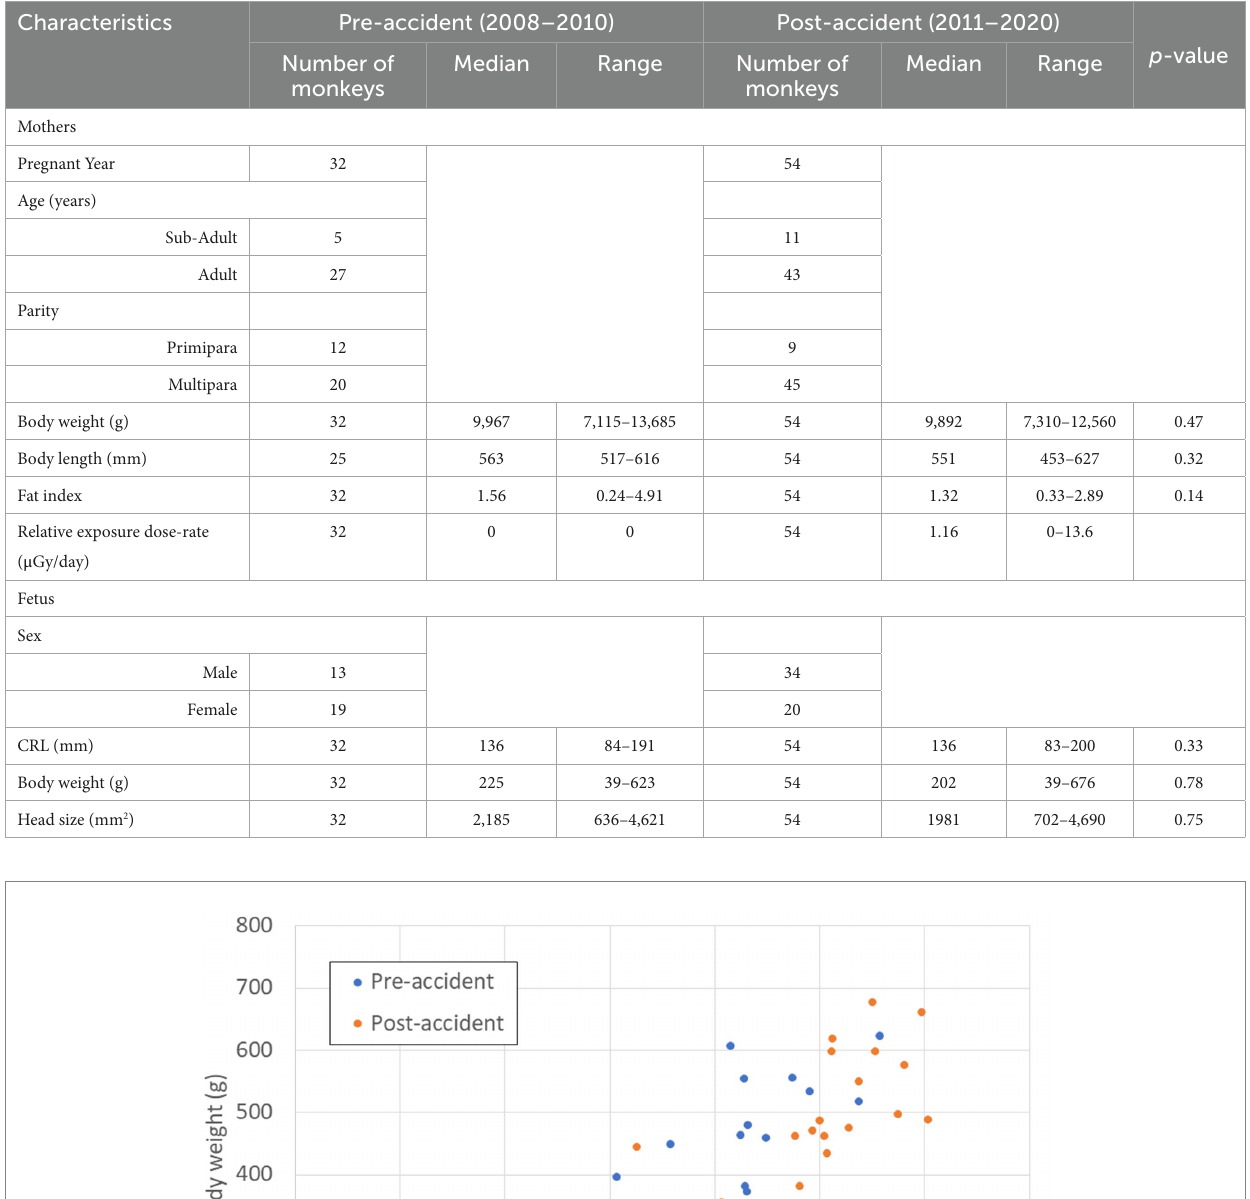
TABLE 1 Characteristics of mothers ( N = 86) and fetuses ( N = 86) based on Japanese monkey carcasses collected in Fukushima, Japan from 2008 and 2020. Characteristics